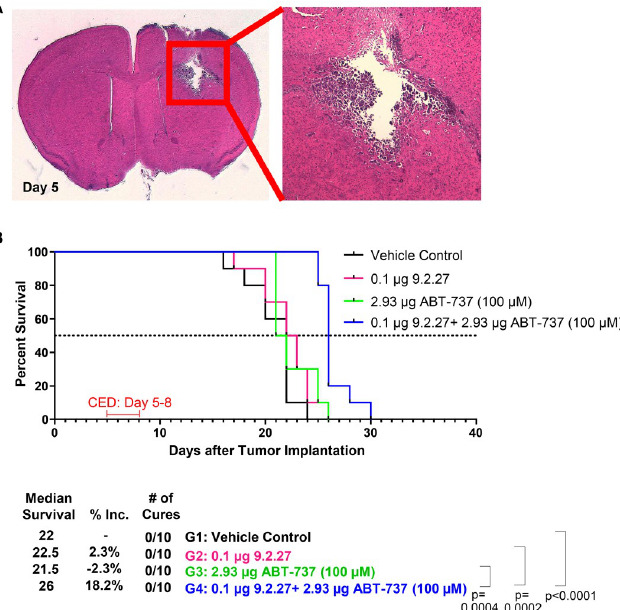
Fig 6. An Intracranial model of melanoma cell line DM440 treated with 9.2.27-PE38KDEL, ABT-737, or the combination. A. H&E staining of a representative mouse brain section harvested on Day 5 post-tumor implantation. B. Survival curve post-therapy and statistical